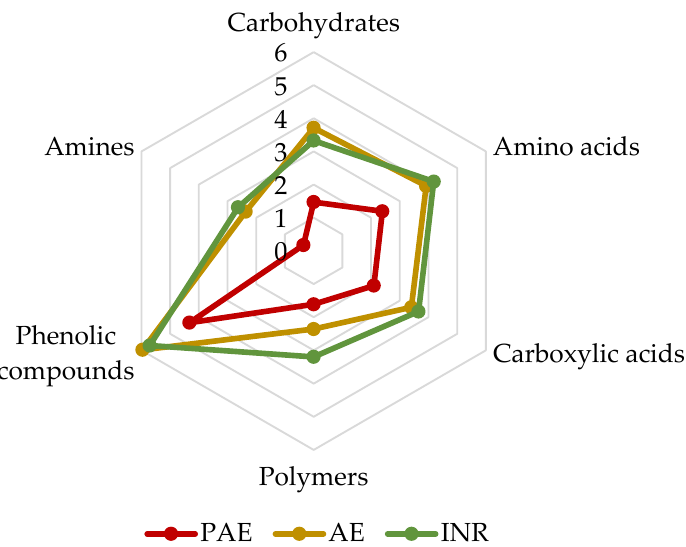
Figure 2. Average well colour development of the six types of carbon sources (SAWCD) after 96 h of incubation. In red Polluted AgroEcosystem (PAE), in yellow AgroEcosystem (AE), in green Integral Natural Reserve (INR).